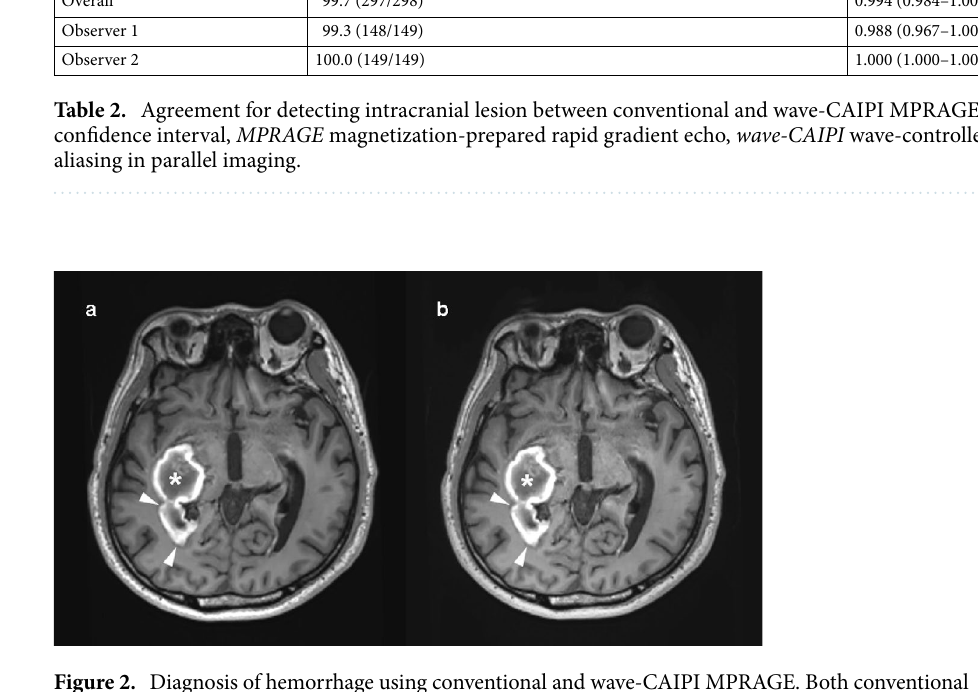
Figure 2. Diagnosis of hemorrhage using conventional and wave-CAIPI MPRAGE. Both conventional pre-contrast 3D T1 MPRAGE ( a ) and wave-CAIPI MPRAGE ( b ) clearly showed subacute hemorrhage in the right basal ganglia (asterisk) extending into the right lateral ventricle, forming intraventricular hemorrhage (arrowhead). MPRAGE magnetization-prepared rapid gradient echo, wave-CAIPI wave-controlled aliasing in parallel